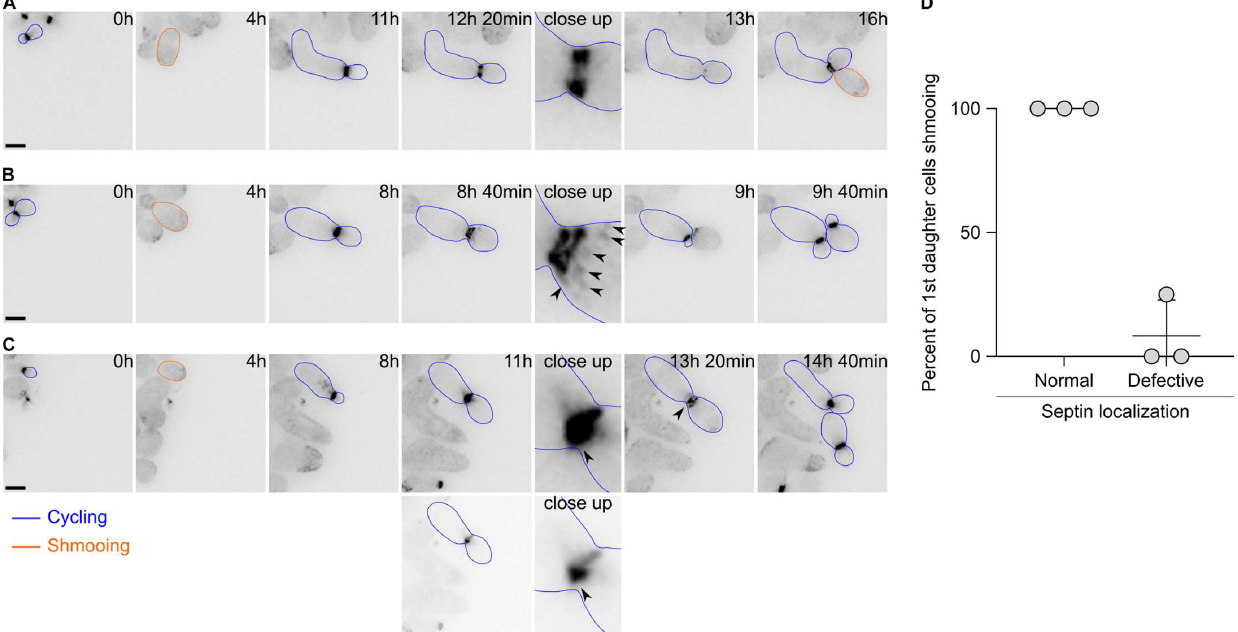
Figure 3. Septin localisation is often aberrant during the first cell division after escape. ( A ) Images of a wild-type cell expressing Cdc10-GFP and displaying a normal localisation during escape. Note that the 1st daughter cell is shmooing upon birth. Scale bar = 5 µ m. ( B ) Same as A except that the Cdc10-GFP signal shows strong patches (black arrowheads) on the bud side and that the 1st daughter cell is budding upon birth. Scale bar = 5 µ m. ( C ) Same as B except that the Cdc10-GFP signal shows a bright accumulation (black arrowhead) at the bud neck. The 1st daughter cell is budding upon birth. The two lower panels depict an adjusted contrast of the same images compared to all other images to better visualise the Cdc10-GFP accumulation. Scale bar = 5 µ m. ( D ) Quantification of the fate of the 1st daughter cells after escape depending on the septin localisation. Average ± SD. N = 3 experiments, with > 60 cells. The p -value = 0.0082 using a Welch’s t